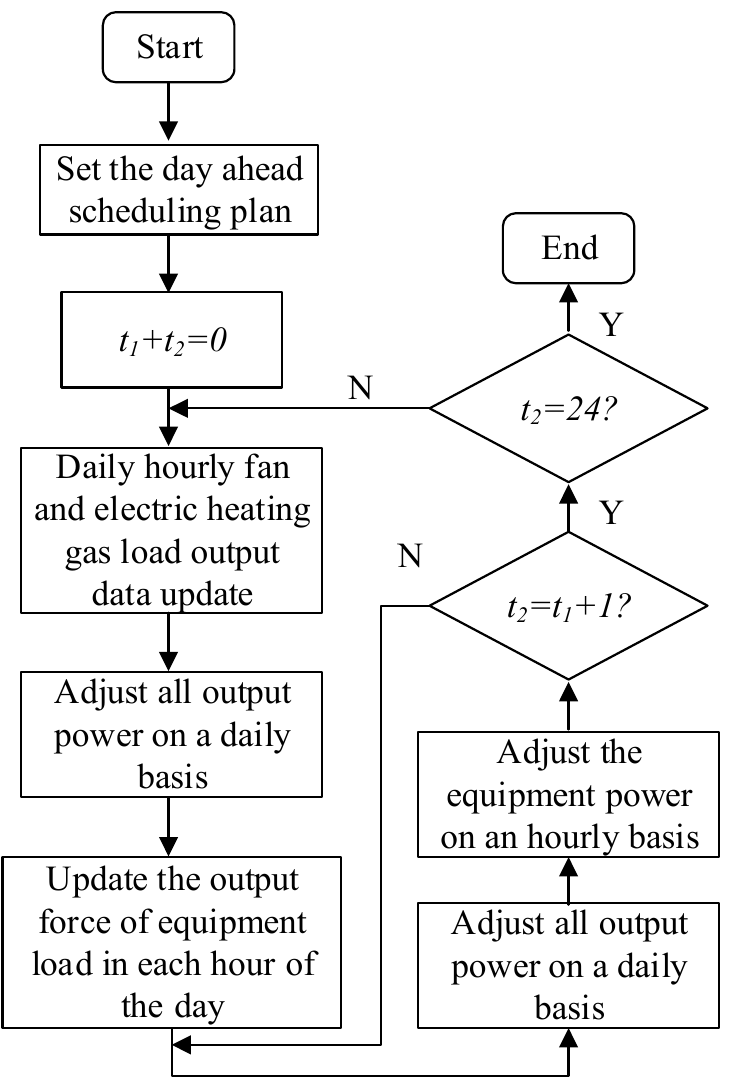
Figure 5. Multi-time scale optimization of energy